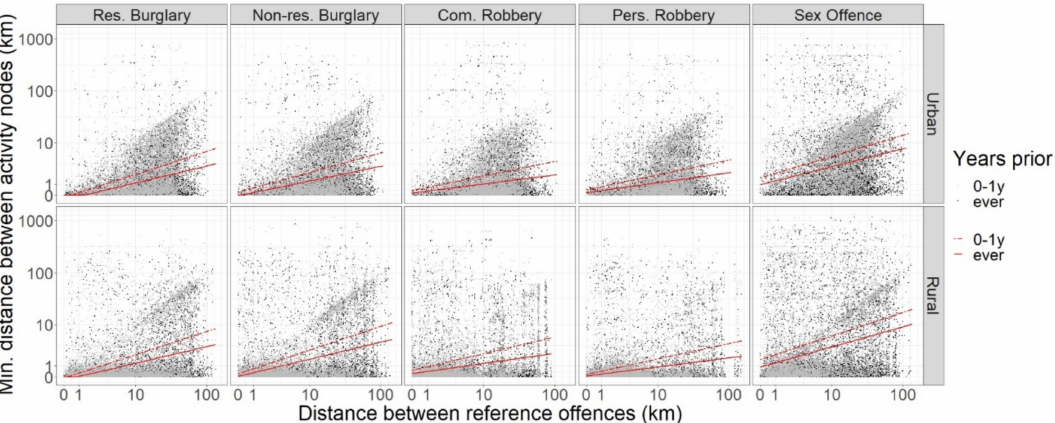
Figure 6. Minimum distance between nearest activity nodes by distance between reference